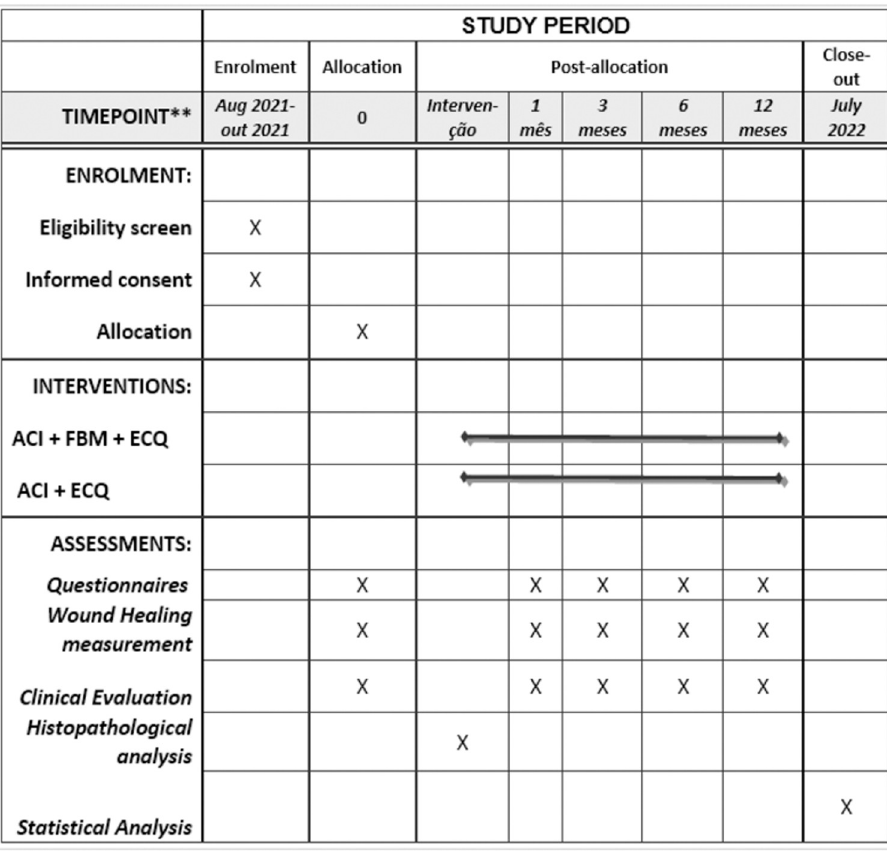
Fig 1. SPIRIT figure as recommended by 2013 SPIRIT